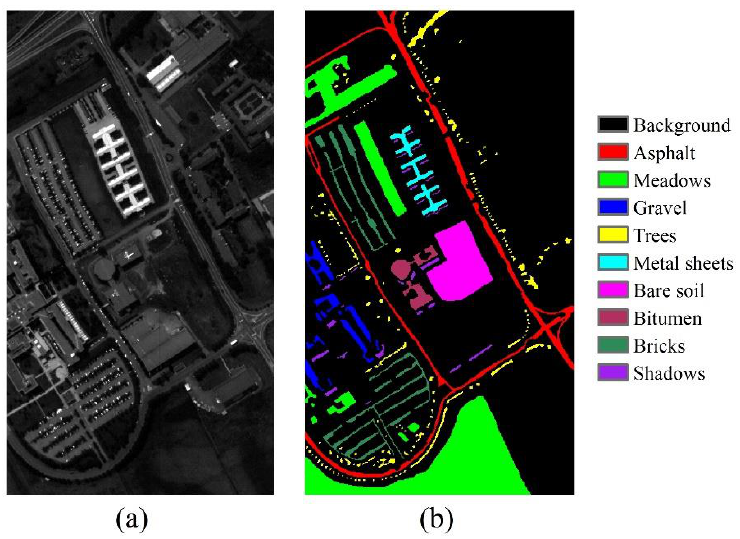
Figure 3. University of Pavia ( a ) sample band (band 10) and ( b ) ground truth image.